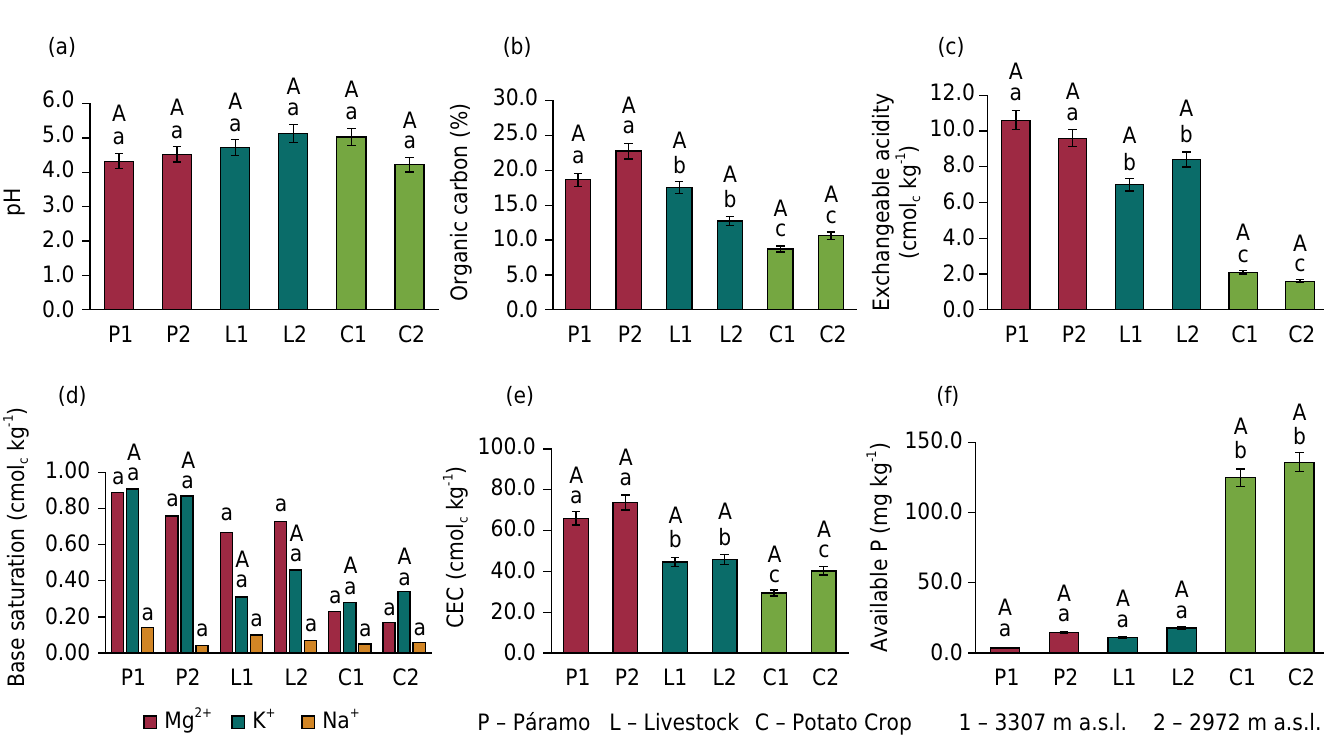
Figure 3. Chemical properties of Páramo soils, potato cultivation, and cattle farming: (a) pH; (b) organic carbon; (c) exchangeable acidity; (d) base saturation; (e) cation exchange capacity; and (f) available phosphorus. * Different lowercase letters on the bars represent statistically significant differences between land uses (p≤0.05). ** Different uppercase letters on the bars represent statistically significant differences between heights (p≤0.05).